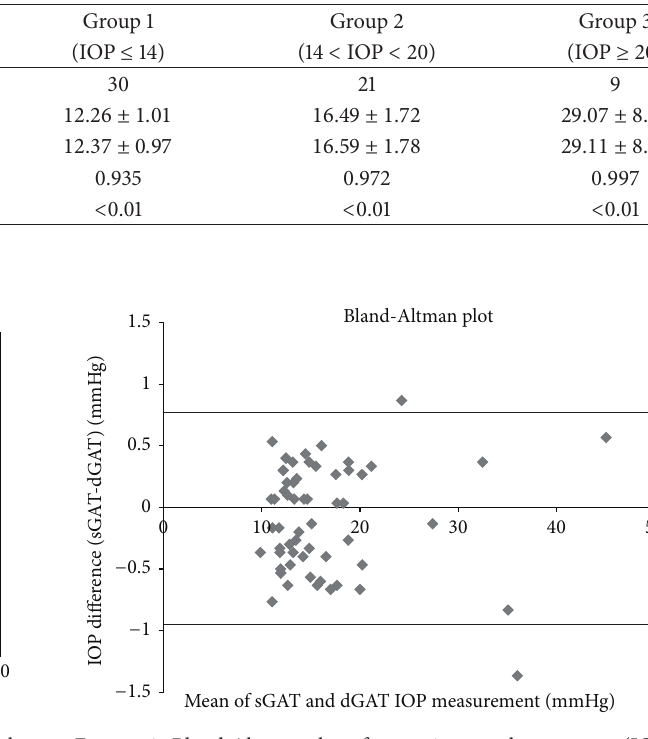
Figure 3: Bland-Altman plot of mean intraocular pressure (IOP) based on standard Goldmann applanation tonometry (sGAT) and digital Goldmann applanation tonometry (dGAT). The mean difference (sGAT-dGAT) was –0.09 mmHg. The 95% confidence interval (mean difference ± 1.96 SD) ranged from –0.95 mmHg to +0.77 mmHg ( 𝑛 = 60 ) as shown by broad lines in the